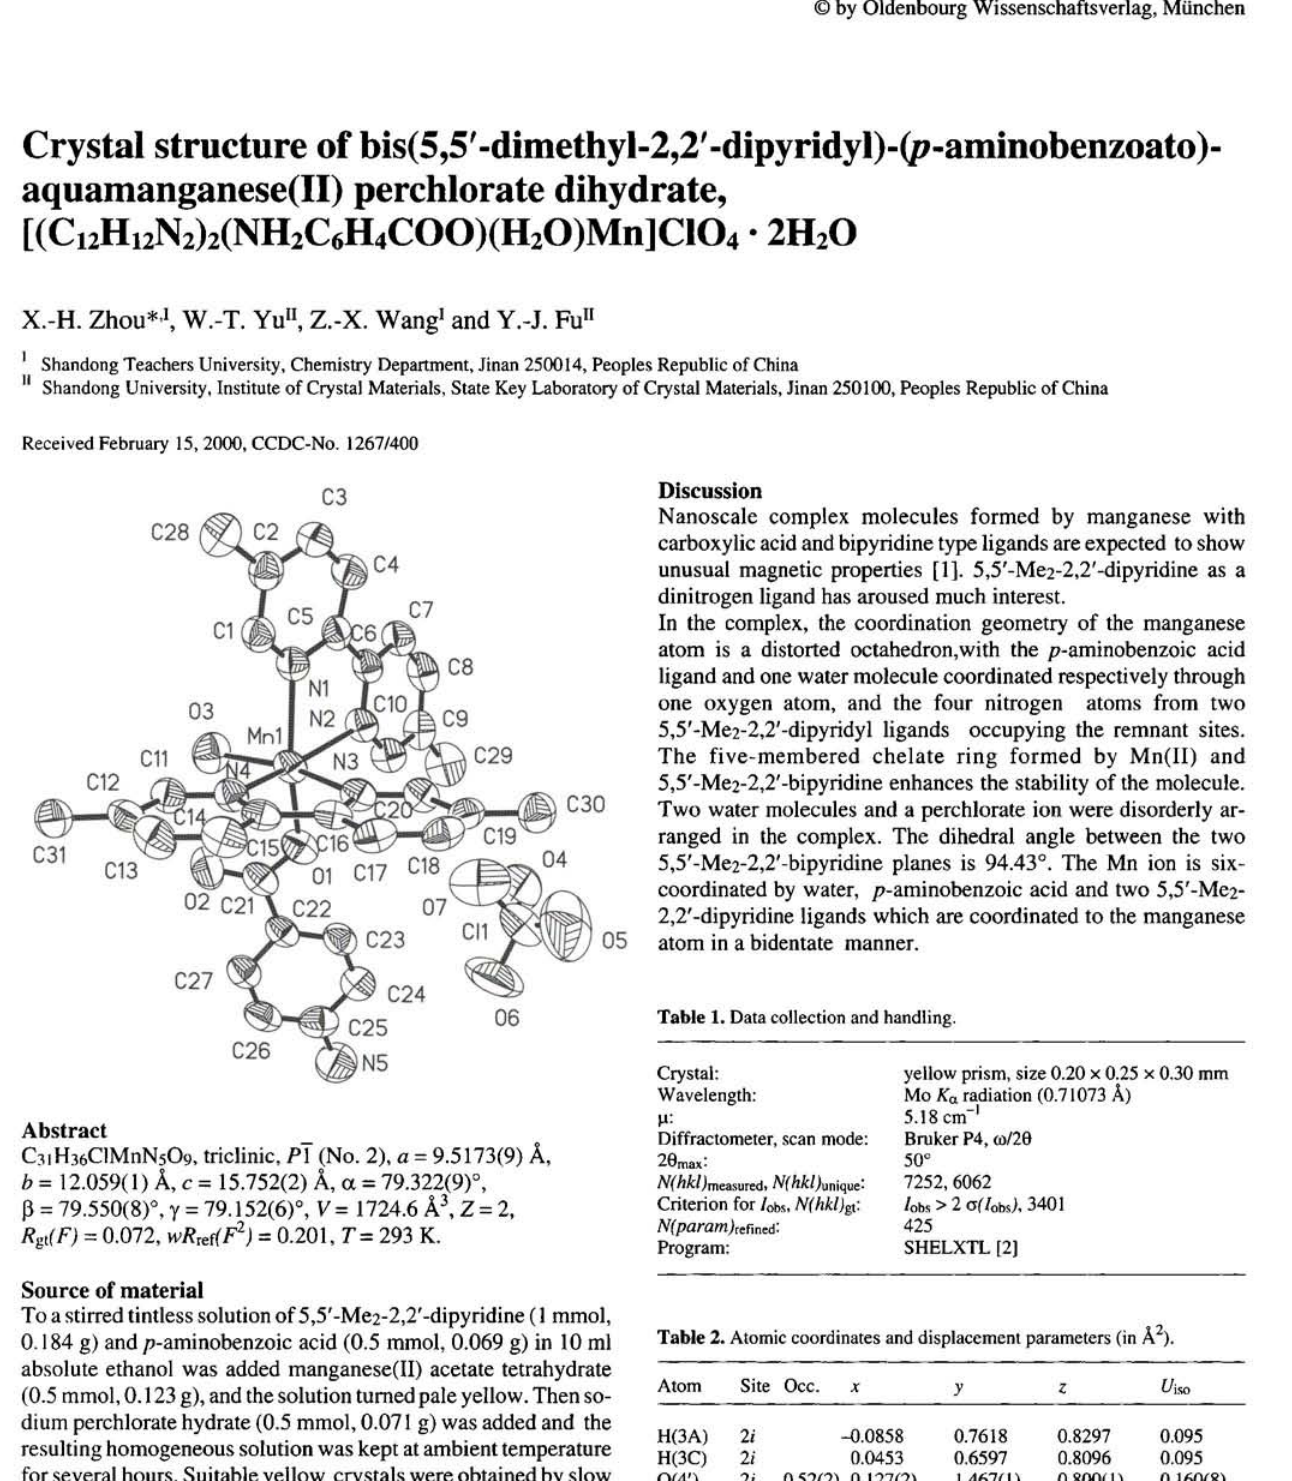
Table 2. Atomic coordinates and displacement parameters (in A 2